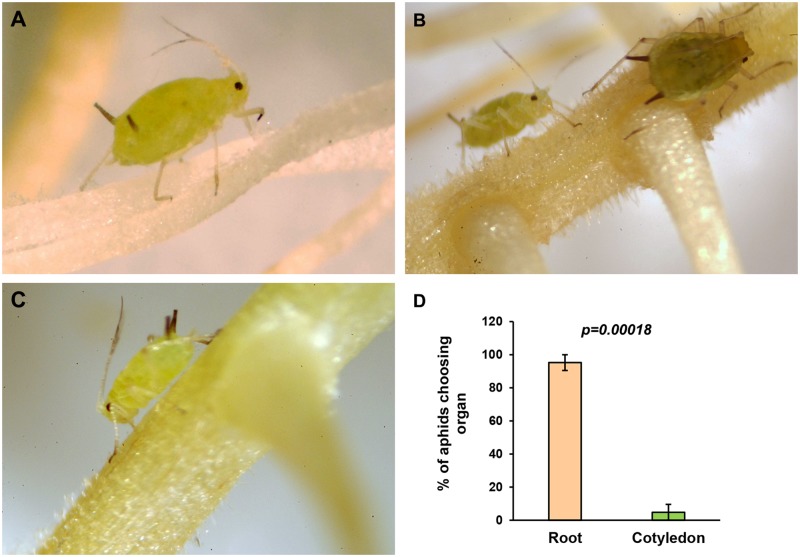
Soybean aphids feed on soybean hairy roots.Aphids were introduced to plates with individual hairy root systems produced by Agrobacterium rhizogenes infection of soybean cotyledons. Roots were kept attached to the cotyledon and the whole system was kept on paper filter wetted with water. Aphids fed on young (A) or older (B, C) roots. D. Quantification of aphid feeding preference. After five days of colonization, the number of aphids feeding on roots or cotyledons was recorded, and the percentage of aphids on each organ is reported. Error bars = standard error. Three independent experiments with three replicates each were analyzed using Student’s t-test.